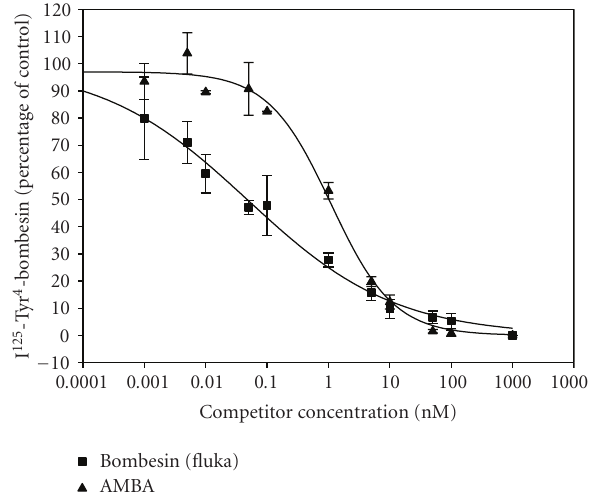
Figure 2: Competitive binding assay of AMBA versus 125 I-Tyr 4 - Bombesin with human bombesin 2